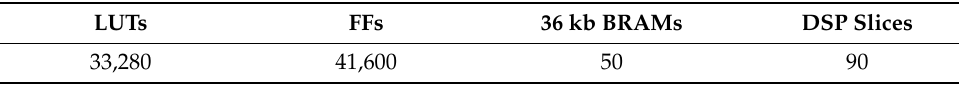
Table 3. XC7A35T FPGA main specifications.